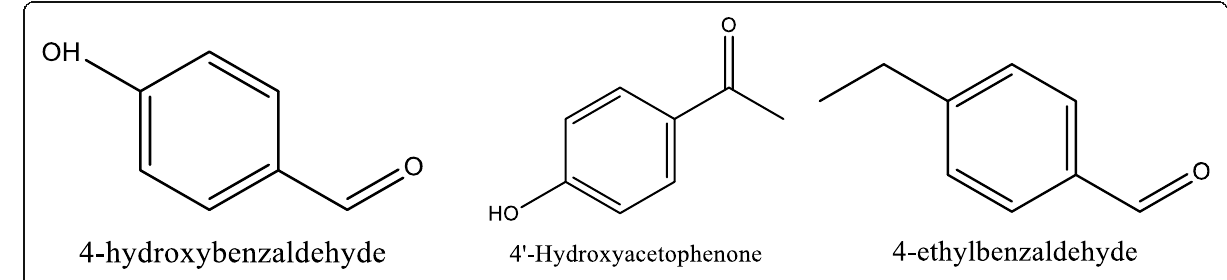
Fig. 17 Chemical structures of some aldehydes isolated from A. vera and A. ferox